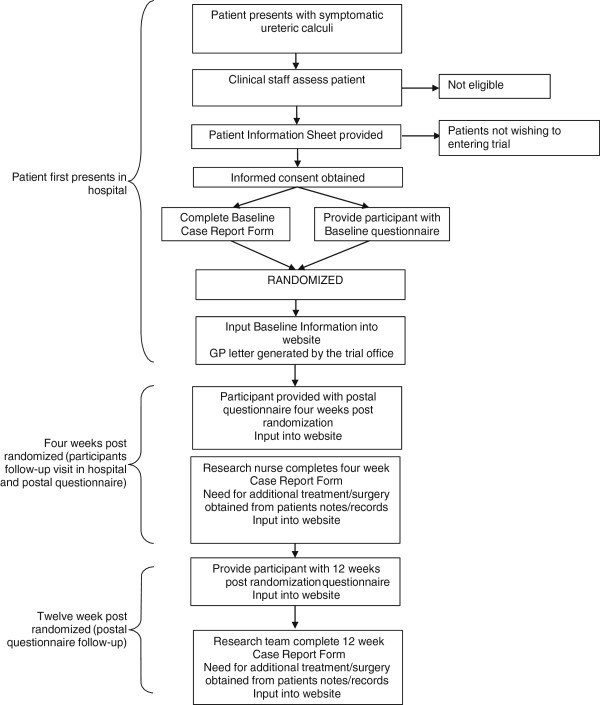
SUSPEND trial processes.